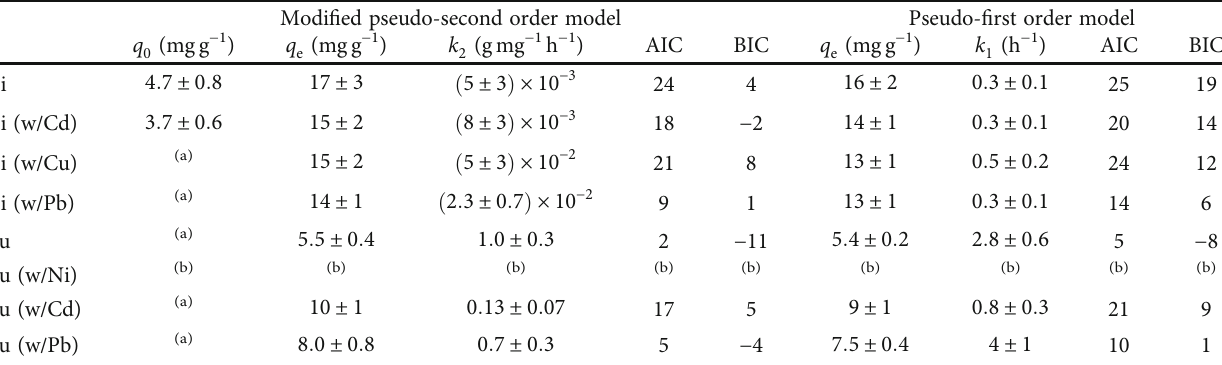
Table 5: Fitting parameters of the kinetic models for the adsorption of nickel and copper isolated and in the presence of interfering ions. Modi fi ed pseudo-second order